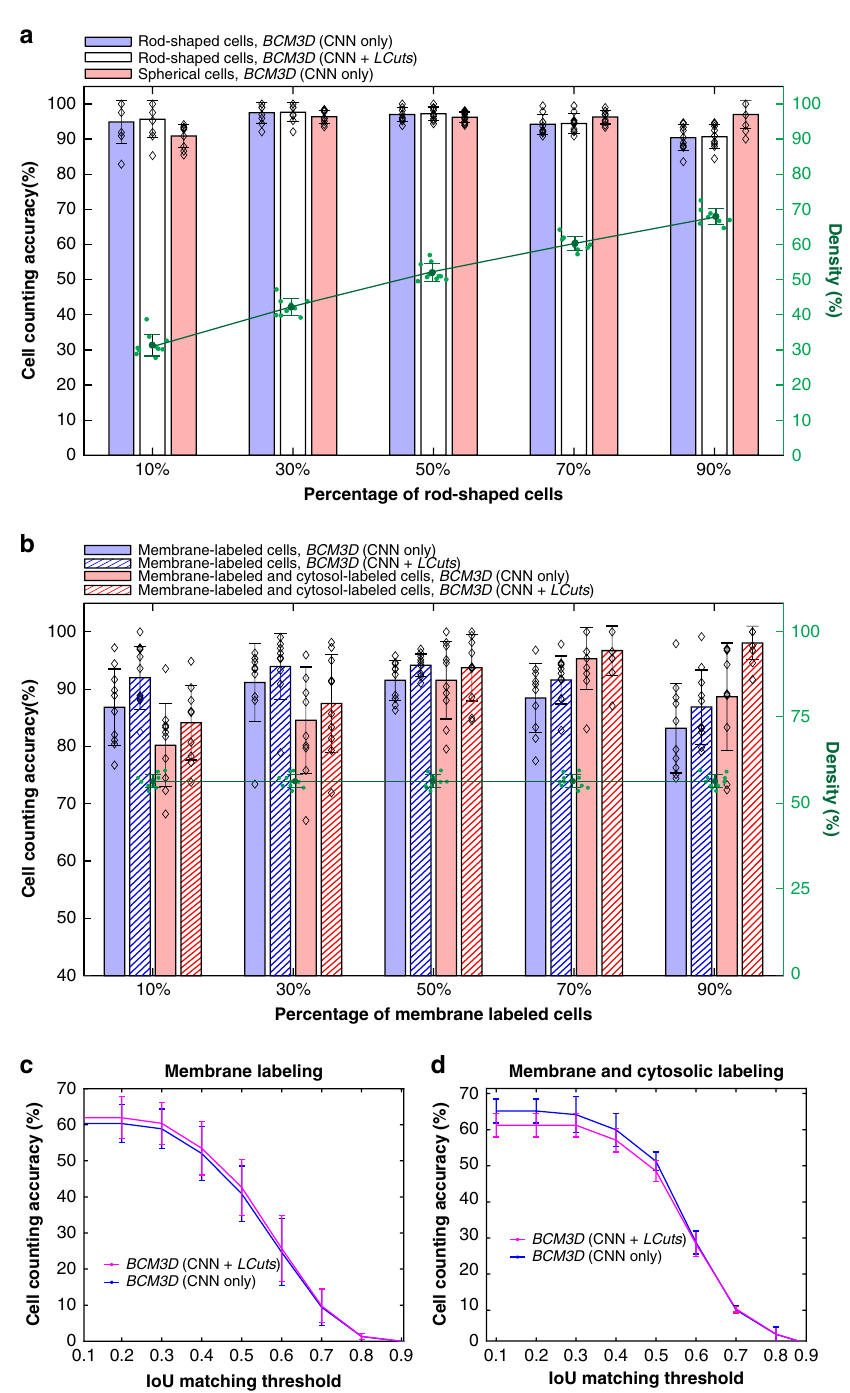
Fig. 6 Performance of BCM3D on mixed population bio fi lm images. a Cell counting accuracy of BCM3D on simulated images containing different ratios of rod-shaped and spherical cells. Black diamonds represent the counting accuracy for N = 10 independently simulated datasets. Green dots represent the cell density for each independent dataset. Error bars represent ± one standard deviation. b Cell counting accuracy of BCM3D on simulated images with different ratios of membrane-labeled, and membrane-labeled and interior fl uorescent protein expressing cells. Black diamonds represent the counting accuracy for N = 10 independently simulated datasets. Green dots represent the cell density for N = 10 independent datasets. Error bars represent ± one standard deviation. c , d Cell counting accuracy of BCM3D on experimental images of c membrane-labeled, and d membrane-labeled and interior fl uorescent protein expressing E. coli cells (mixing ratio ~1:1). Each data point is the average of the cell counting accuracies calculated using annotation maps traced by three different researchers ( N = 3). Data are presented as mean values ± one standard deviation indicated by error bars. Source data are provided as a Source data fi le for Fig.